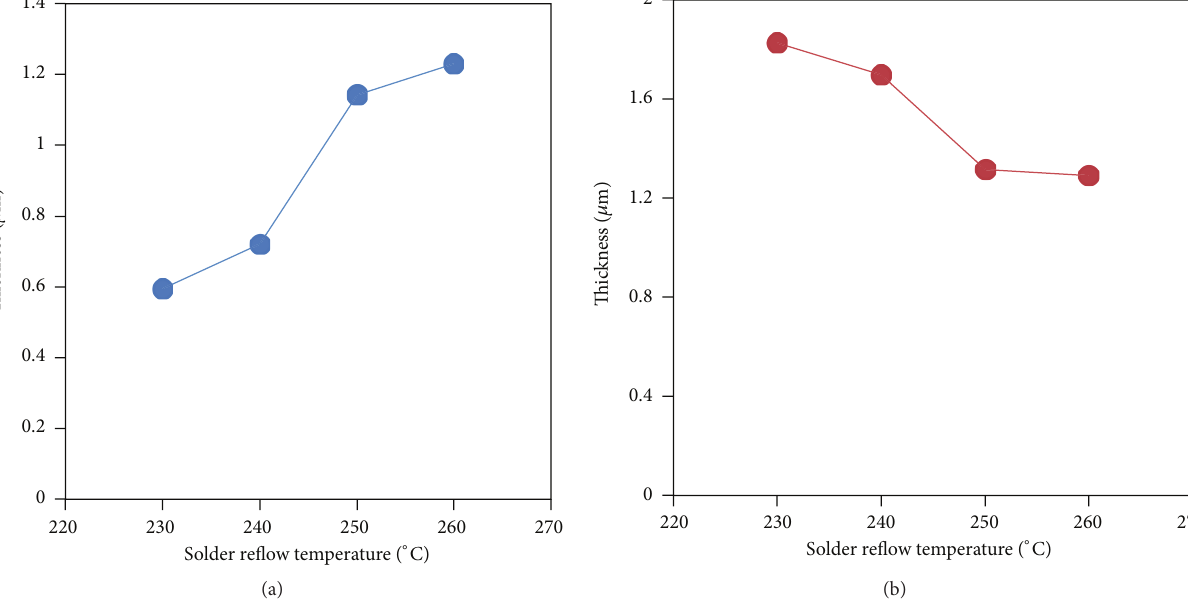
Cu 6 Sn 5 decreased. Cu 3 Sn maintained its continuous layer- like morphology with increasing thickness and reflow time (Figure